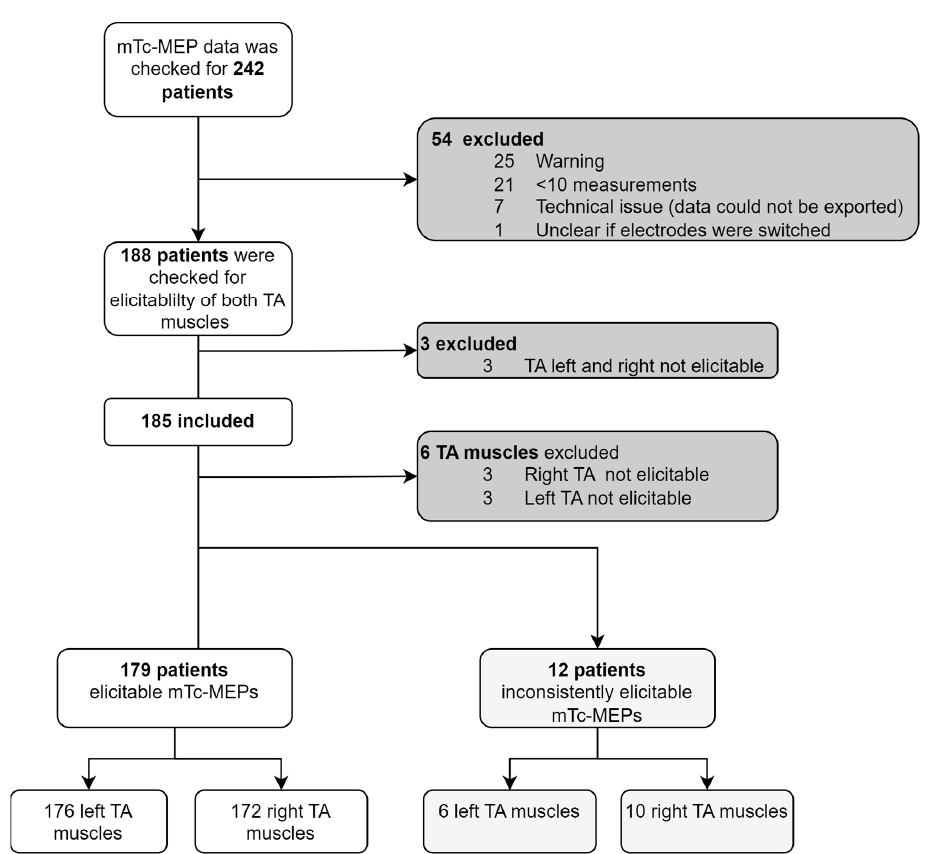
Figure 3. Flowchart patient selection. TA, tibialis anterior; mTc-MEP, muscle transcranial electrical stimulation motor evoked potential. Table 1. Baseline patient